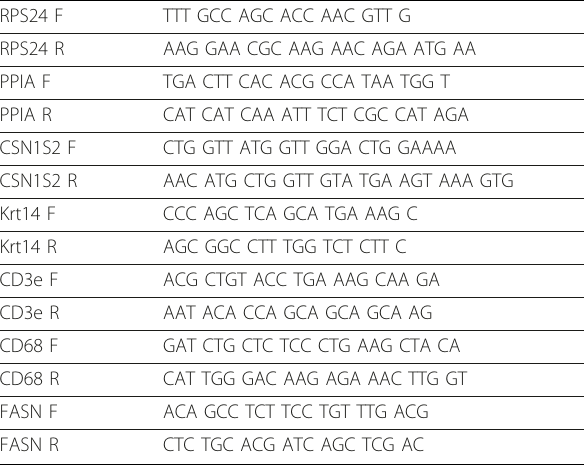
Each pair of primers amplifies the target cDNA in its 3 ’ region. Primer pairs were designed with the Primer Express Software v2.0 (Applied Biosystems) except for RPS24 primers which were manually